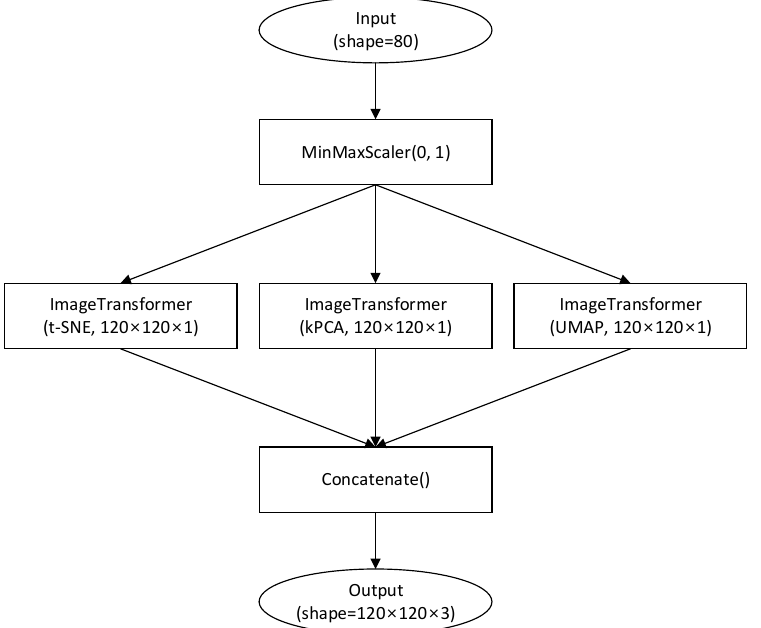
Figure 3. Final 3-channel RGB color image created using grayscale images generated by t-SNE, kPCA (cosine), and UMAP, which are the image transformers with the highest F1-score values.